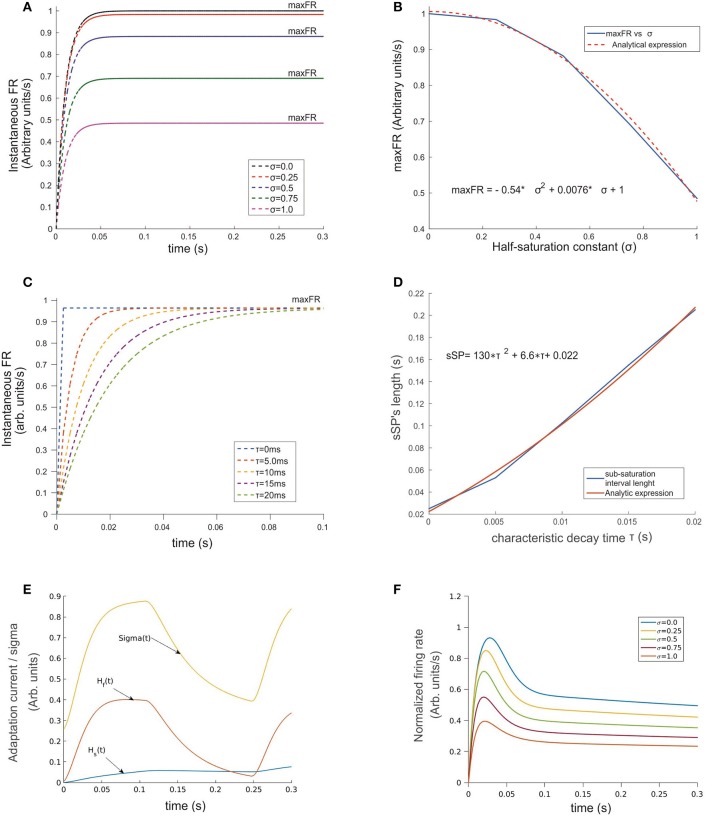
Temporal evolution of the ST-neuron's firing rate. (A) For a constant input, the amplitude of the firing rate has a transitory pre-saturation period which is independent of the half saturation constant σ. However, after this point and depending on its magnitude, increasing σ led in a minor or major proportion the saturation rate of the cell to fall and reach smaller maxFRs. (B) Analytical expression of the relation between variables depicted in (A) firing rate and σ are related through a quadratic function for which small values of σ near 0 rapidly makes maxFR ≅ M. (C) A similar relation rules the effect of τ on the time required by the firing rate to saturate when σ was kept fixed. The simulation shows strong modulation before the 100 ms point of each simulation. In spite of maxFR remaining unchanged, the duration of the sub-saturation period increased proportionally to τ following the trend plotted in (D). A representation of the temporal pattern for the fast (Hf) and slow (Hs) components of the Ih-current is shown in (E). The combined effect of the two components modulates the firing rate by adding temporal dependence to σ (see Equation 2 section Methods), whose dynamics is represented by the top trace in (E). The response of the top cell in (F) shows the effect on the FR-profile when submitted to the action of the synaptic inputs and the activation of Ih. Here the values of σ are identical to (A). Note in the latter the decaying post-saturation profile and the generation of bumps before reaching the stationary firing regime.